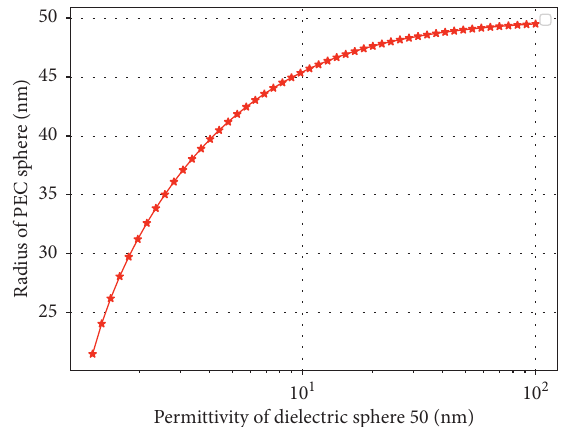
Figure 3: Relationship between the different dielectric constants of the dielectric sphere ( R � 50nm) and the equivalent radius of the metal